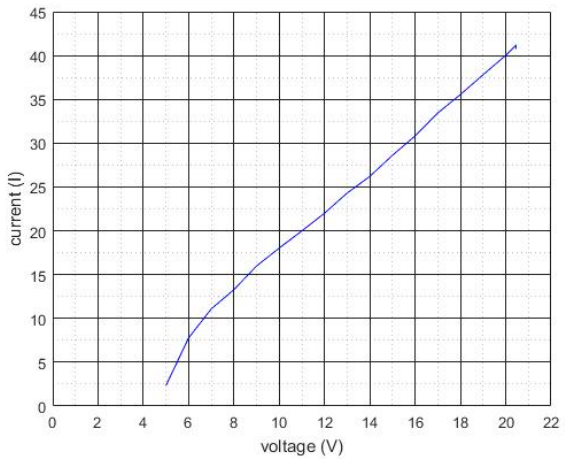
Figure 10. Current profile with varying throttle percentage of the UAV.